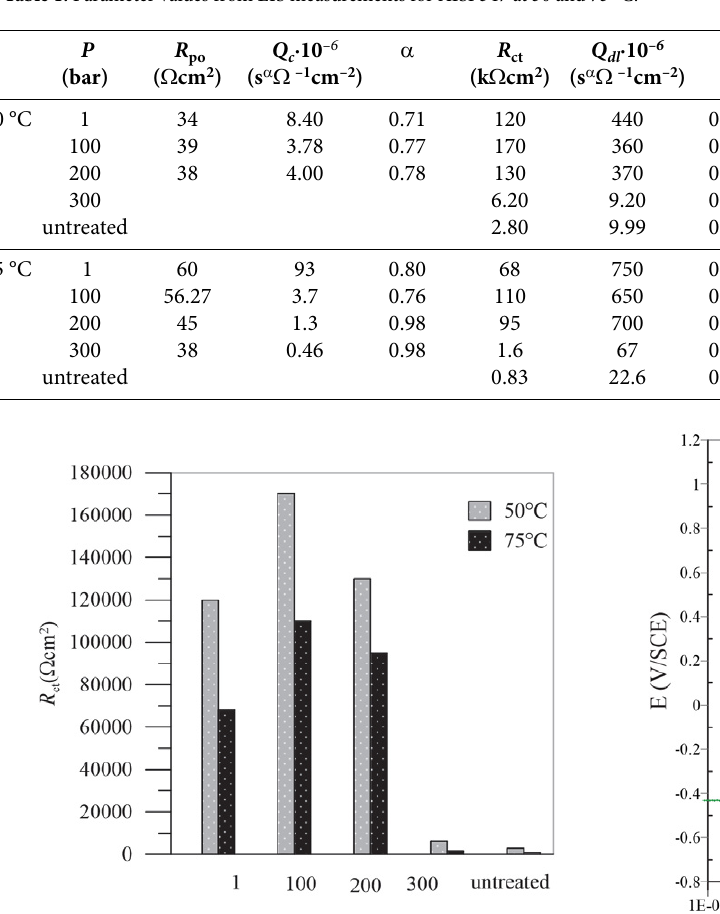
Figure 8. Calculated charge transfer resistance for AISI 347 at 50 and 75 °C depending on the pressure treatment. Figure 9. Polarization curves for AISI 347 at 50